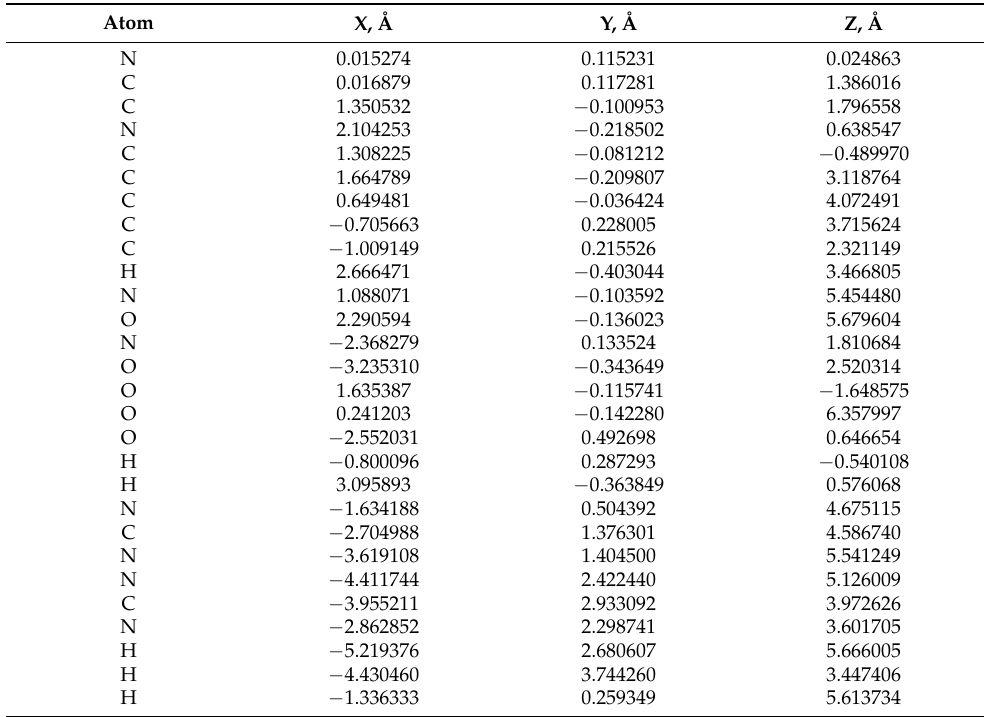
Table A5. Convergent geometries of